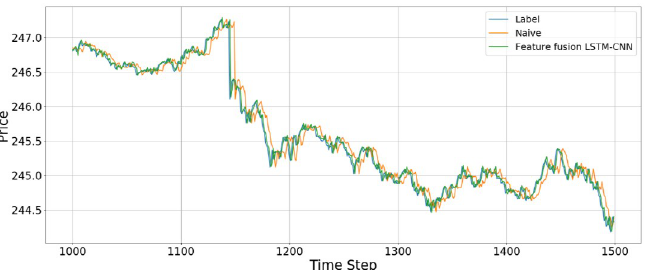
Fig 17. An example of predicting stock prices using the feature fusion LSTM-CNN model with a test dataset of between 1,000 and 1,500 data points. The input data are candlebar chart and stock time series.